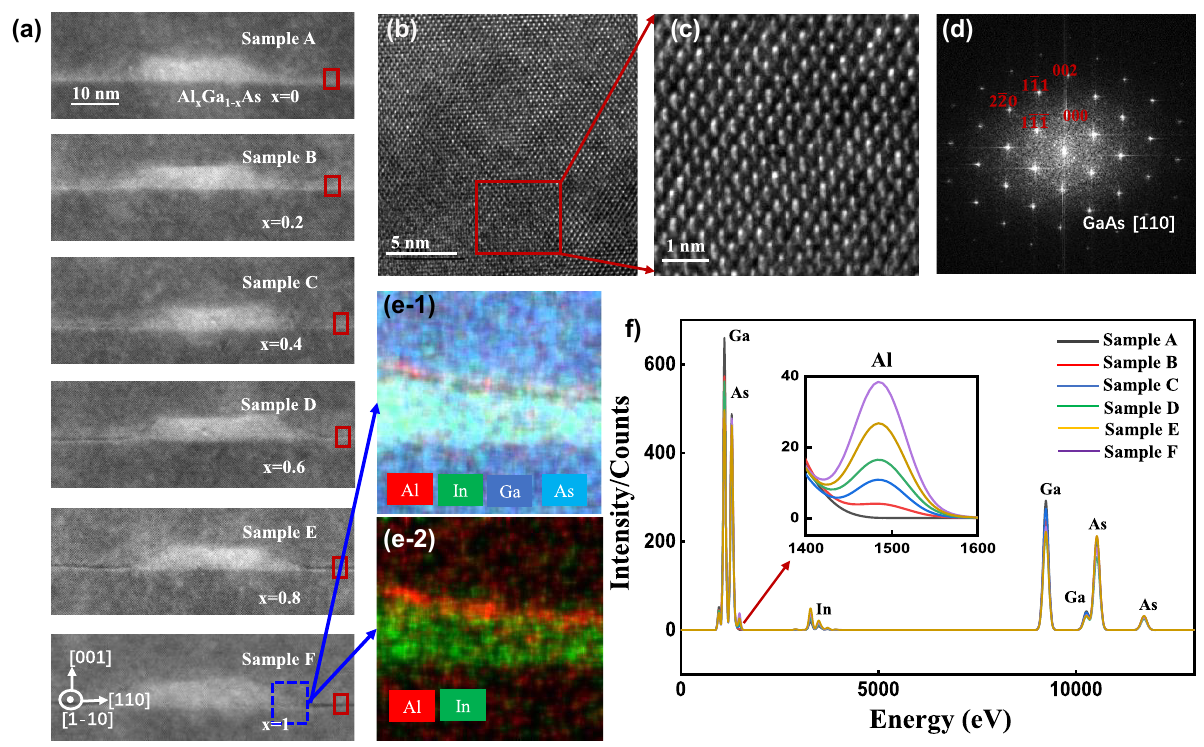
Figure 1: Morphologic properties of samples A – F. (a) STEM images taken along the [110] crystallographic direction of samples A – F, respectively. (b and c) High-resolution TEM images of the GaAs region. (d) The selected-area diffraction patterns in (c). (e) EDX elemental mapping of the blue box in sample F. (f) EDX element quantitative measurement of samples A – F with the same area of 3.5 × 3.5 nm from the red boxes in